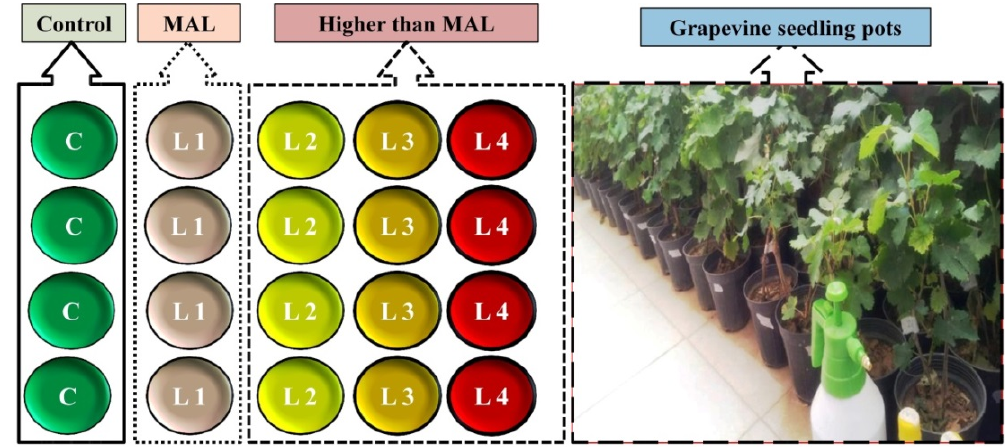
Figure 1. Schematic design of the treatment for each studied metal (C: control, L1 to L4: level 1 to level 4 stressed, MAL: maximum allowed level) and image of applied grapevine seedling pots.